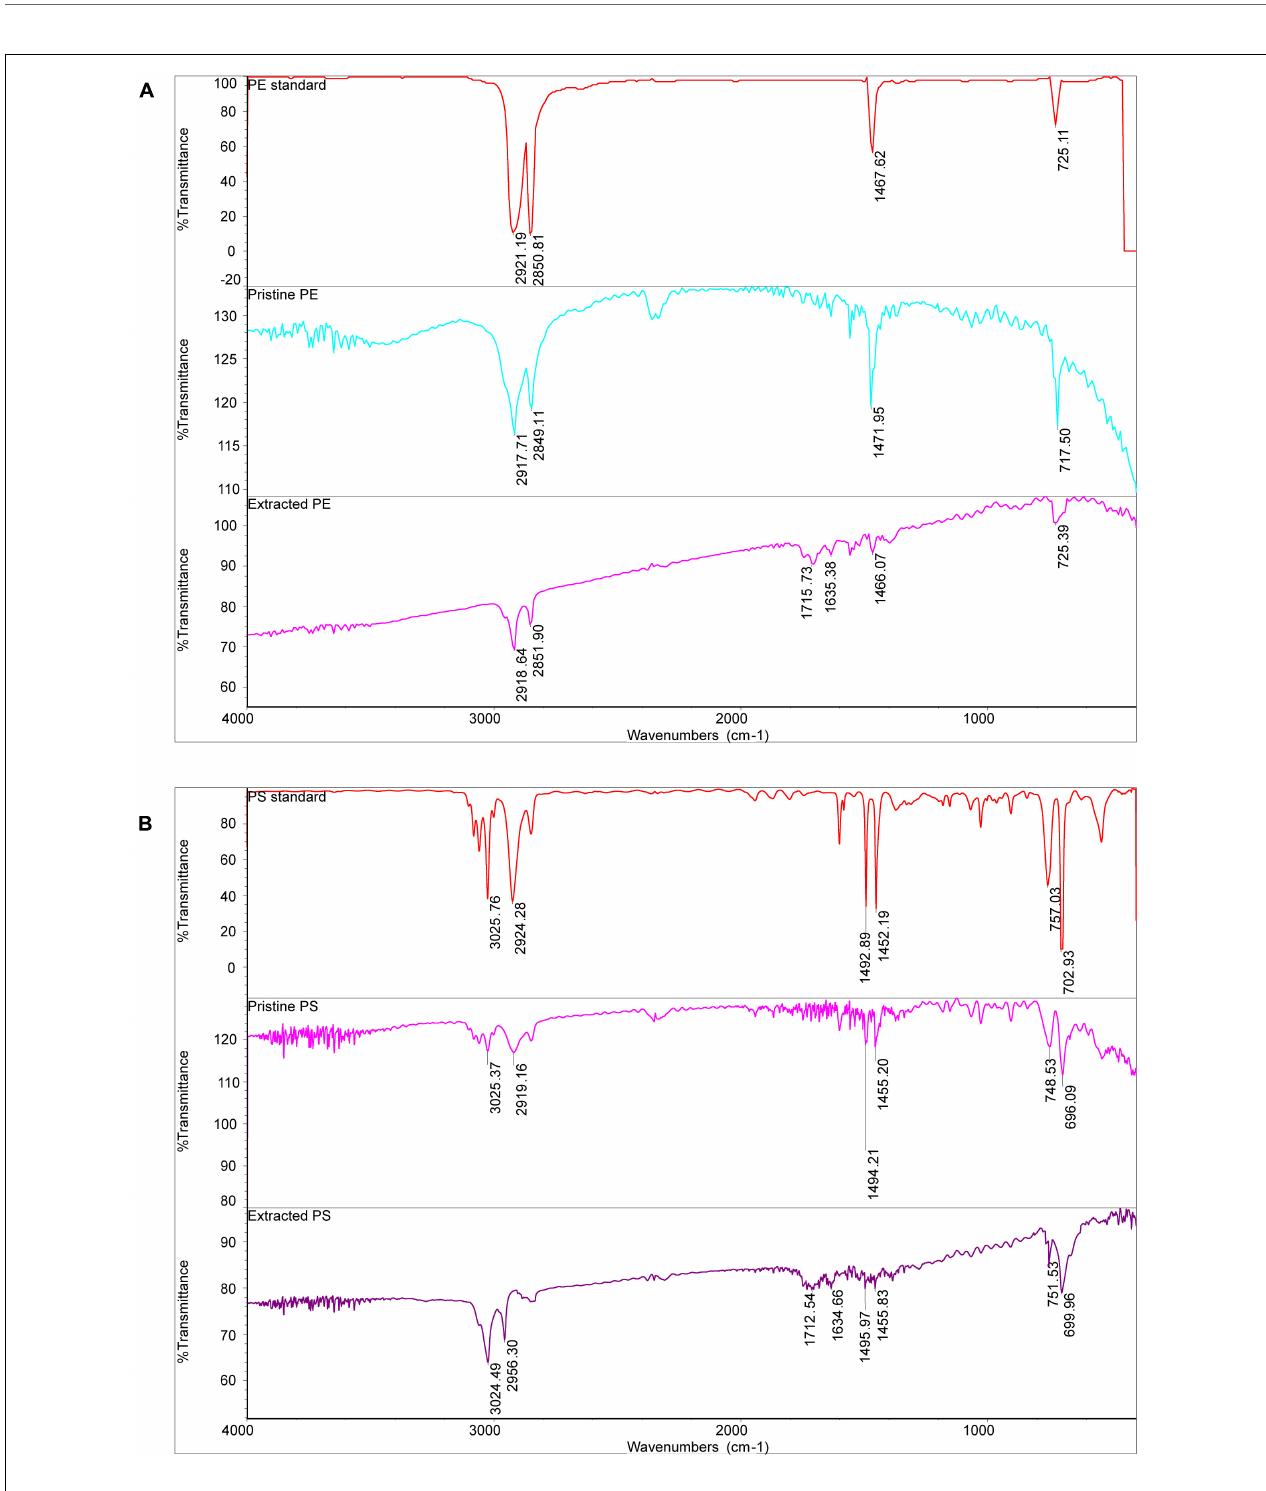
FIGURE 4 | The FTIR spectra of PE MPs (A) and PS MPs (B) .